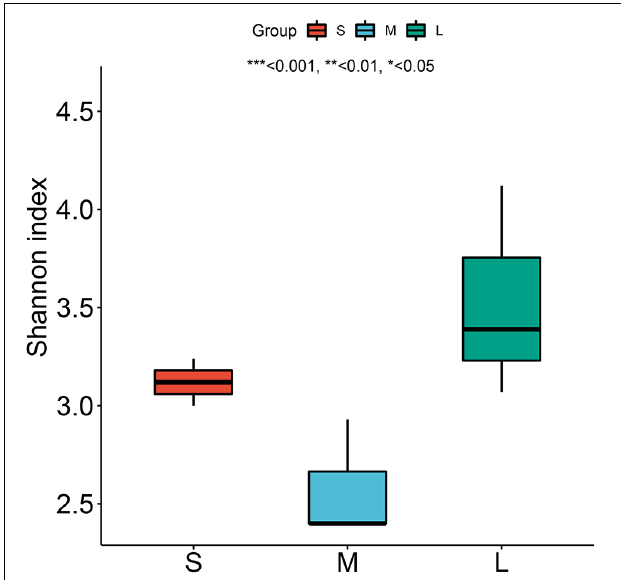
FIGURE 6 | Shannon diversity index for yellowfin sea bream at the species level. * means P < 0.05, ** means P < 0.01, and *** means P < 0.001.